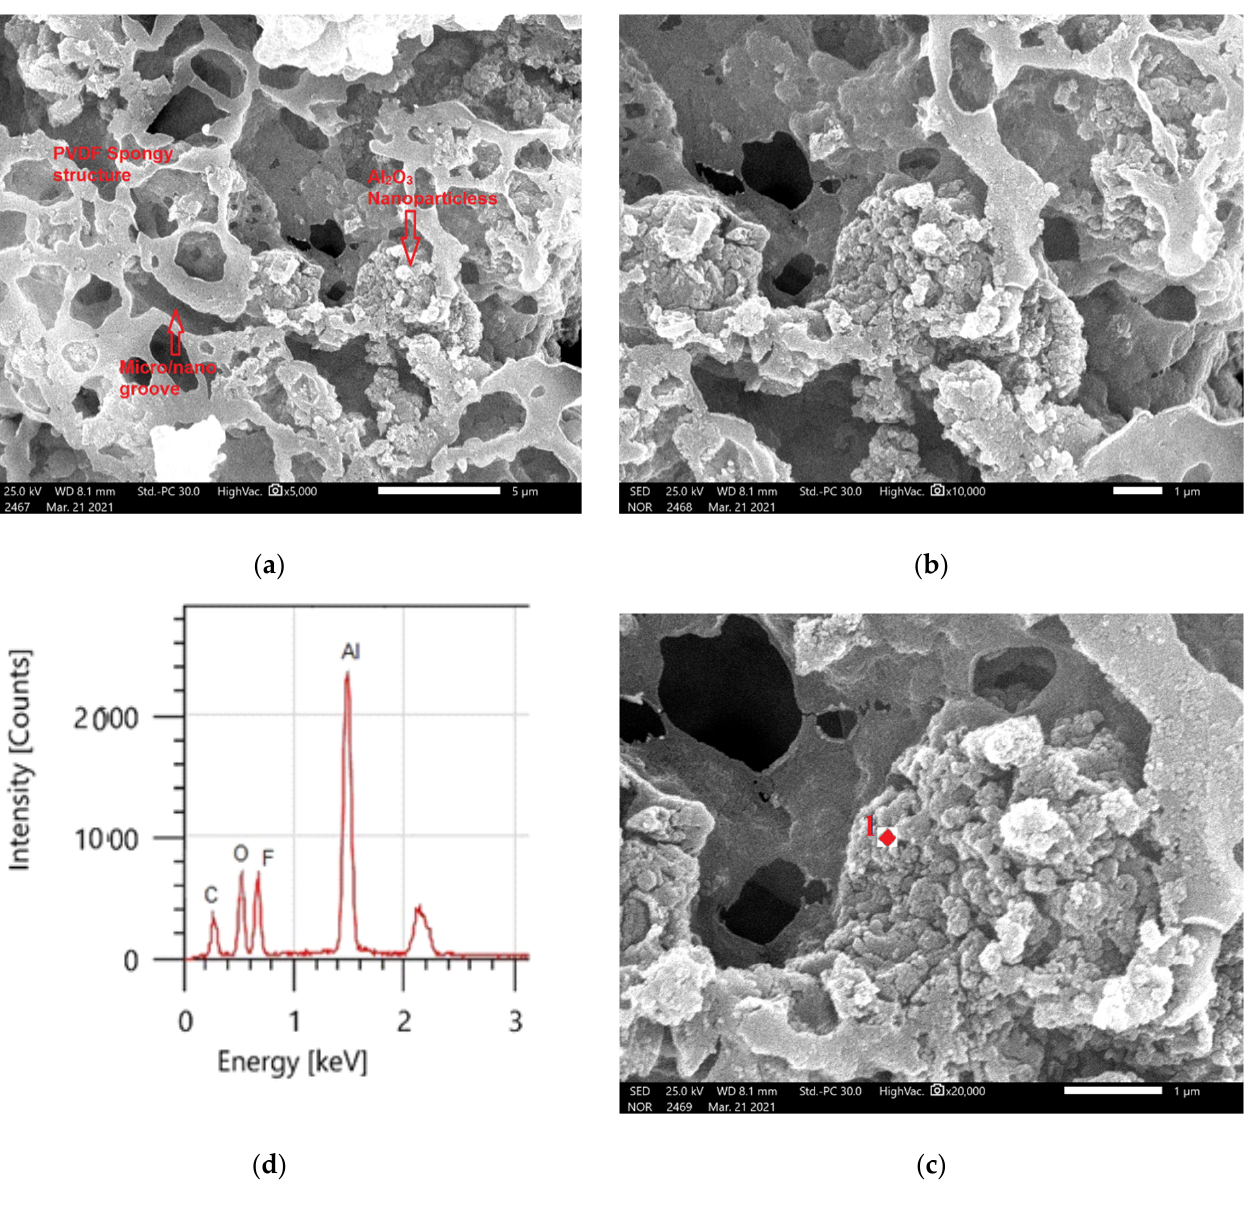
Figure 8. ( a – c ) PVDF composites containing 1.5 g Al 2 O 3 at different magnifications, as shown by SEM and ( d ) EDS analysis of point 1 in ( c ). Table 3. EDS analysis of surface elements for PVDF alone and PVDF–Al 2 O 3 composite coatings